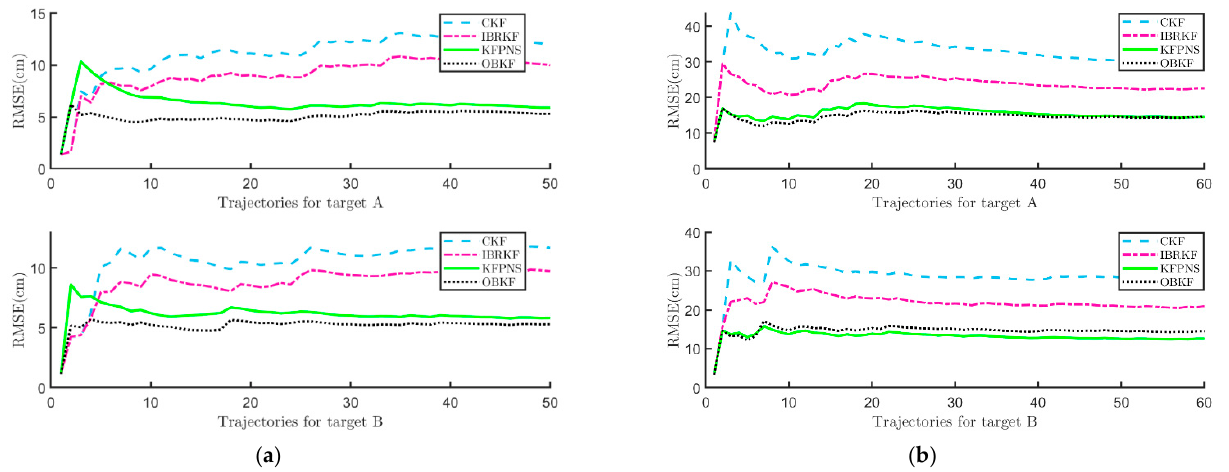
Figure 11. The RMSE of various Kalman filtering methods in different scenes. ( a ) The RMSE of the four Kalman filtering methods in an indoor scene with respect to target A and target B, respectively. ( b ) The RMSE of the four Kalman filtering methods in an outdoor scene with respect to target A and target B, respectively. Table 3. The MMSE difference of various Kalman filtering